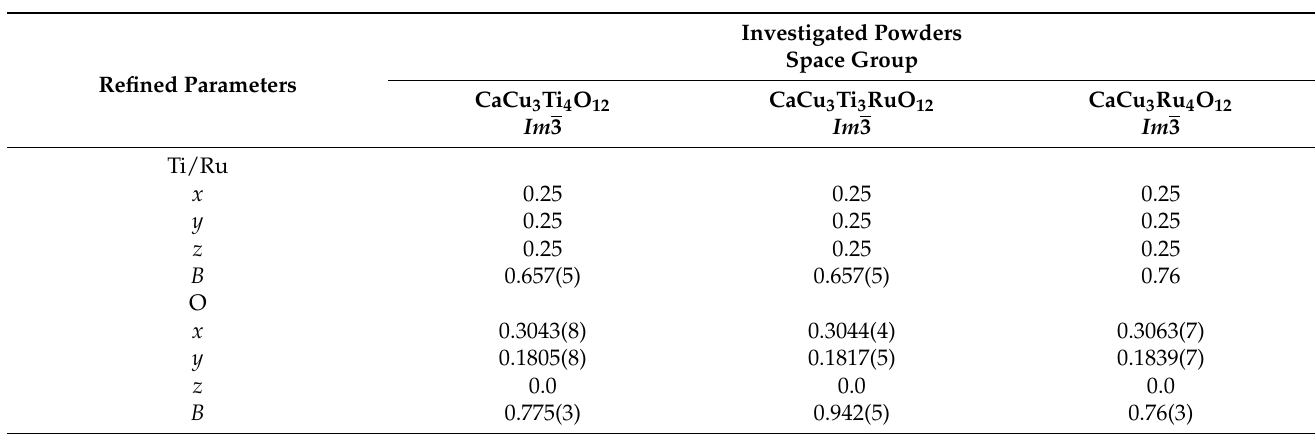
Ru 4+ cation in the CaCu 3 Ti 4 − x Ru x O 12 crystal